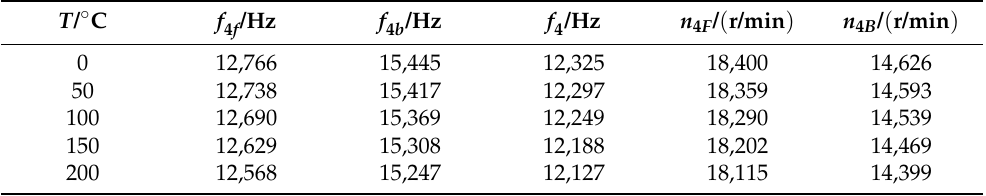
Table 7. TWR speed and frequencies of 4th predicted by static frequency in different